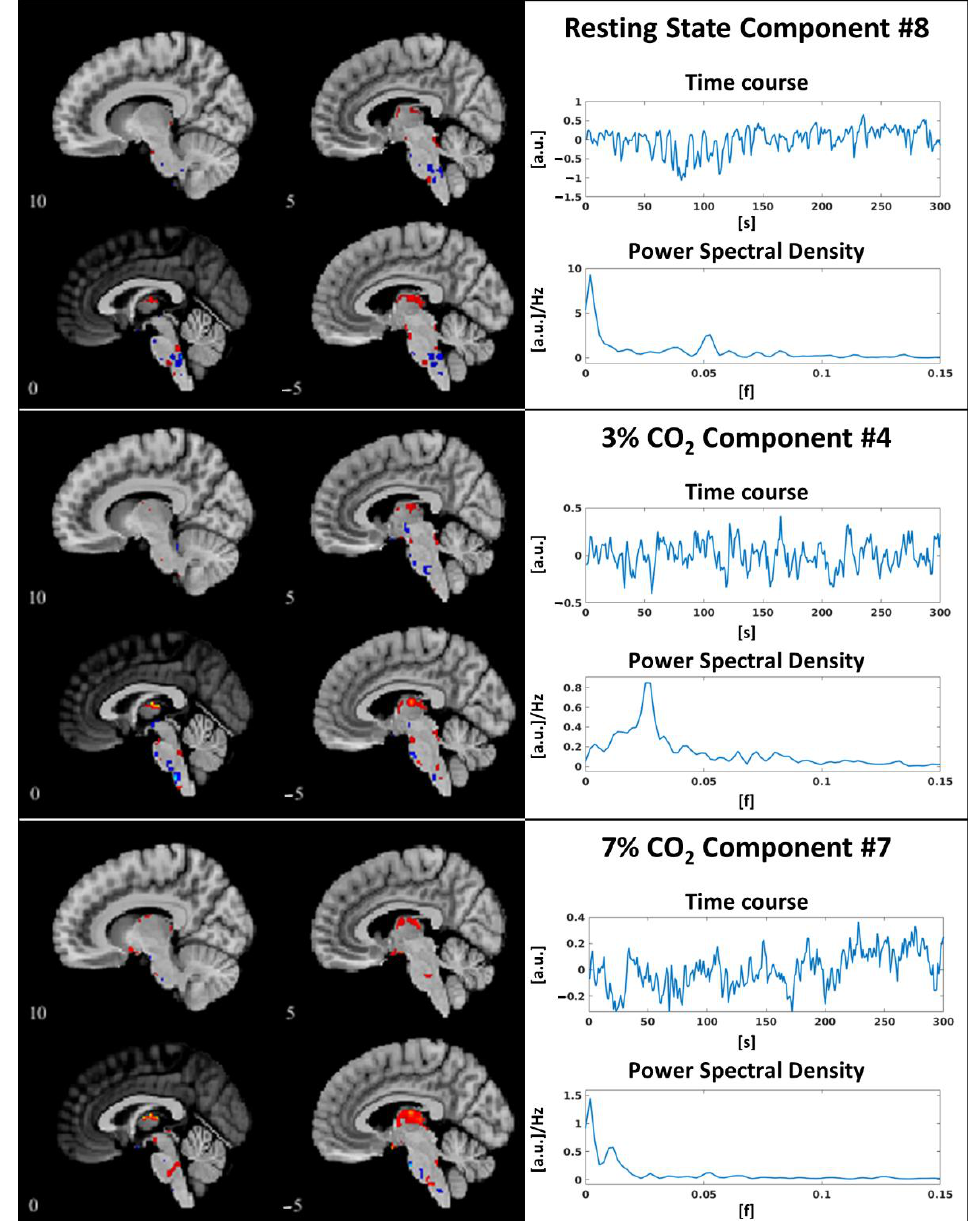
Figure 4. Triplet selected for the analysis performed using the subcortical mask.